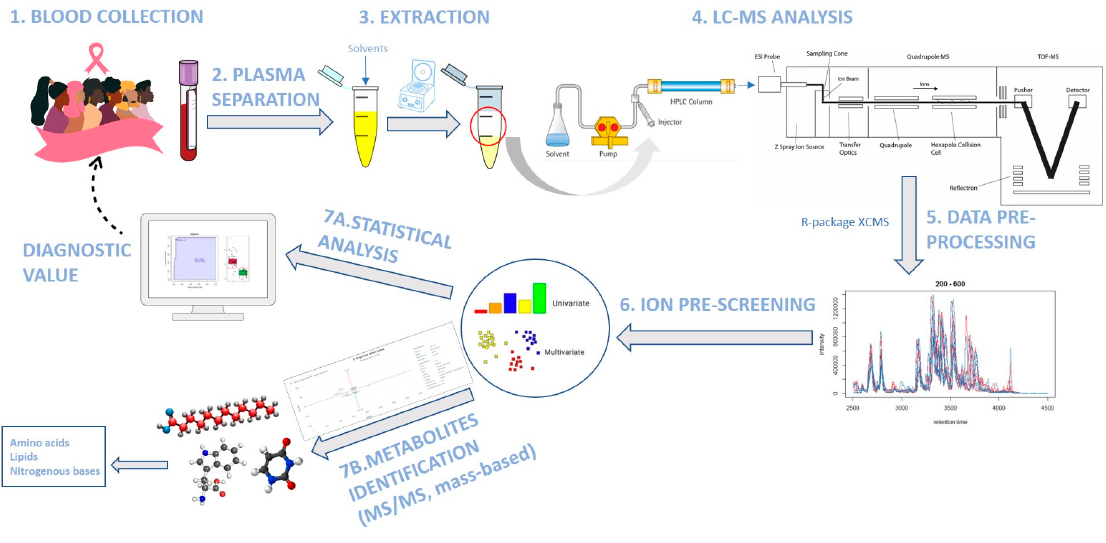
Figure 6. Summarized steps of the Materials and Methods sections. Supplementary Materials: The following supporting information can be downloaded at: https: ethyl ester; Figure S2: Matched spectra for 5-[(4-Nitrobenzoyl)amino]isophtalic acid; Figure S3: Matched spectra for Ile-Ser; Table S1: Putative identities, based on a mass-based search, for